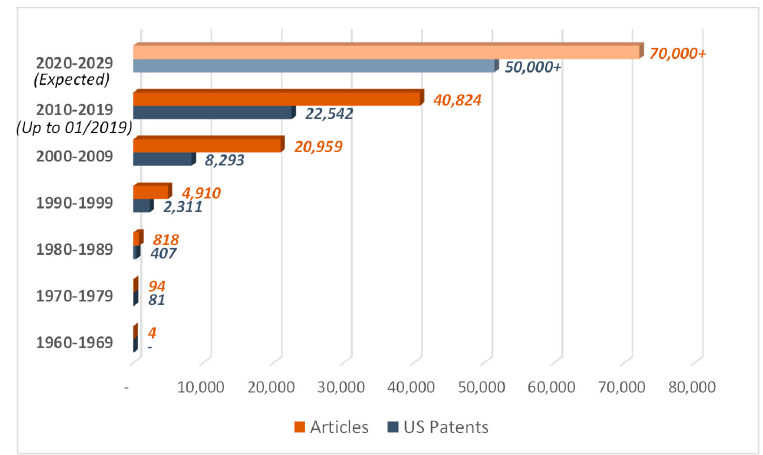
Figure 12. Articles published and U.S. patents issued. Sources: Scopus and Uspto. Keywords: “Shape Memory Alloy” OR “Nitinol”. Retrieved: 22/01/2019.